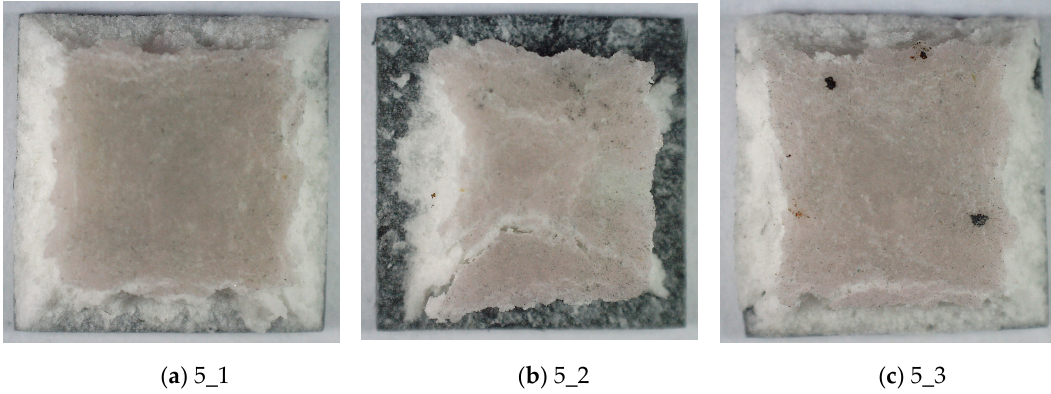
Figure 11. The TBC ceramic mats of samples after compressive impact tests at 55 °C. ( a ) sample 5_1 ( b ) sample 5_2 ( c ) sample 5_3.